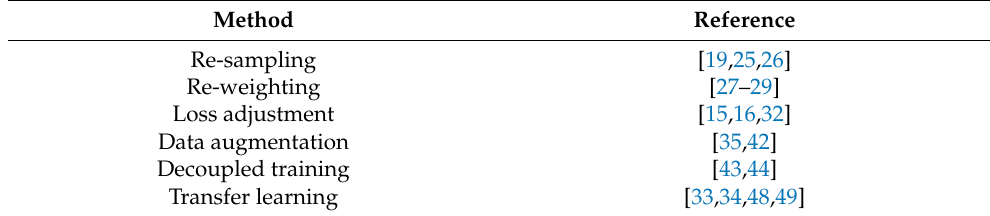
Table 1. Summary of different learning approaches under class